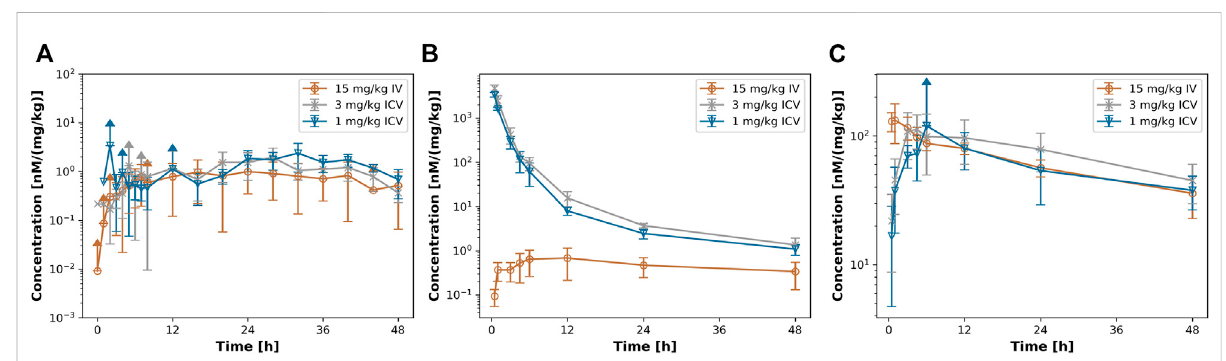
FIGURE 2 dose-normalized PK pro fi les after iv or icv dosing. Figure 2 shows the dose normalized PK pro fi le in (A) ISFbrain. (B) CSF and (C) serum after 15 mg/kg iv (orange) 3 mg/kg ICV (grey) and 1 mg/kg icv (blue) of